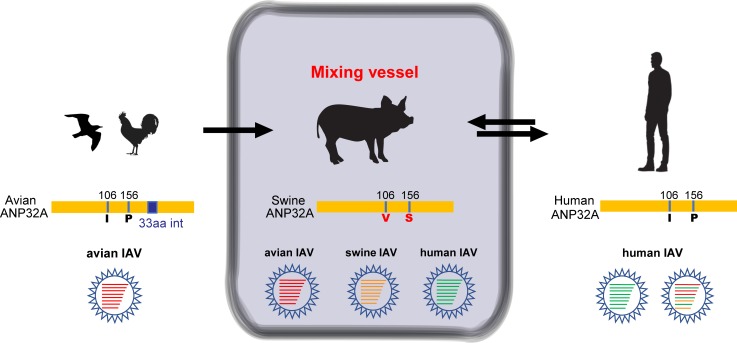
Proposed model of ANP32 proteins as “the key” for the inter-species transmission of avian influenza A virus in different species.AIVs can replicate and transmit naturally in birds. Pigs are thought to play an important role in influenza virus transmission and triple-reassortant virus generation, because they are susceptible to both avian and mammalian influenza viruses, and different species of influenza viruses can therefore genetically recombine in pigs, producing new strains that can transmit to humans. Avian ANP32A can support the replication of the avian influenza virus due to an additional 33-aa insertion; huANP32A only can support the polymerase activity of mammalian or mammal-adapted (e.g. PB2 E627K, or D701N) viruses, but not that of avian viruses); as swANP32A contains a unique active site 106V/156S, it can support the replication of not only all mammalian influenza viruses, but also avian influenza viruses. The co-infection of two or more virus strains in pig providing more chances to produce new recombinant strains, which can spread to other mammals such as humans.